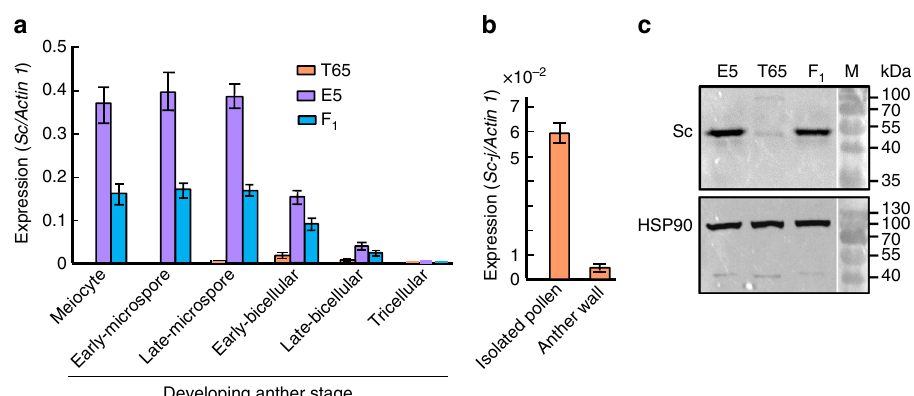
Fig. 2 Expression of the Sc alleles. a Expression of Sc-i and Sc-j in the developing anthers of E5, T65, and their F 1 by qRT-PCR using a common primer pair (P3/P8, Supplementary Fig. 1) for all the alleles/ Sc-i paralogs (except for Sc-is ). The values (means of three biological replicates with s.e.m.) were normalized to OsActin 1 transcript levels. b qRT-PCR analysis of Sc-j (using P3/P8) in separated pollen and anther wall cells (at early-bicellular stage) of T65. Data are shown as means ± s.e.m. ( n = 3). c Different Sc protein abundances in anthers (at stages of uninucleate late-microspore to early-bicellular pollen) of the parents and the F 1 , detected with anti-Sc